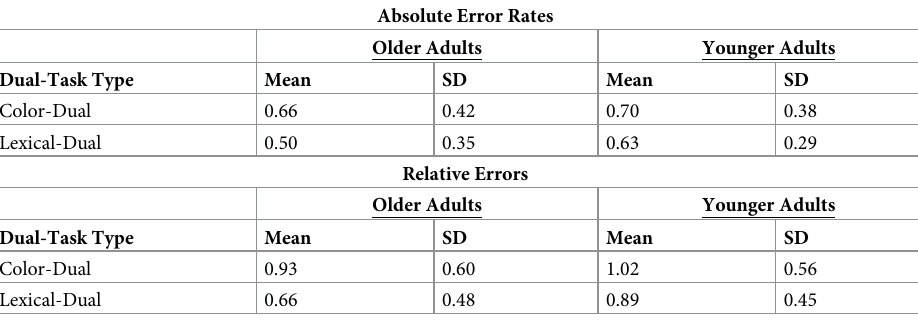
Table 5. Dual-task descriptive statistics for secondary task